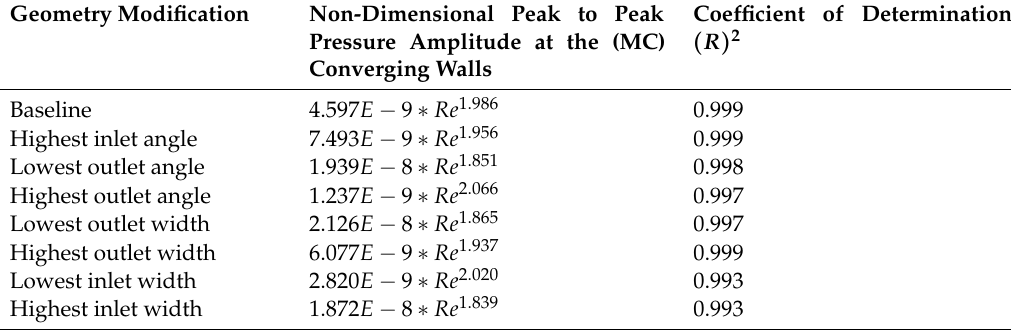
Table 5. Equations characterizing the evolution of non-dimensional peak to peak stagnation pressure amplitude at the (MC) outlet converging walls, and as a function of the Reynolds number. These equations are valid in the range 8711 < Re <